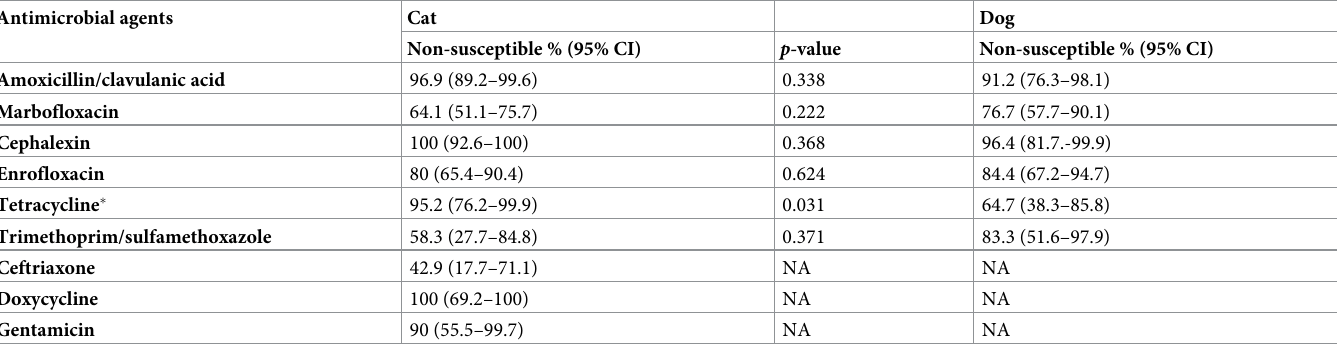
NA- Not analyzed (data with isolates less than 10 were not analyzed); � Significant difference between cats and dogs, P < 0.05.